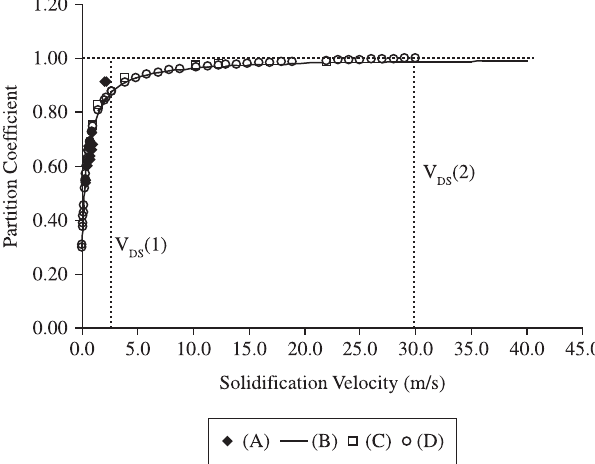
Figure 8. The effect of solidification velocity on As partition coefficient in Si-As alloy: A) experimental 8 ; B) equation 2 ,4 and 5 using K C) Phase field calculation; and D) Sobolev’s fitting; V fitting Sobolev’s model to higher velocity experimental data; V from fitting Sobolev’s model to phase-field